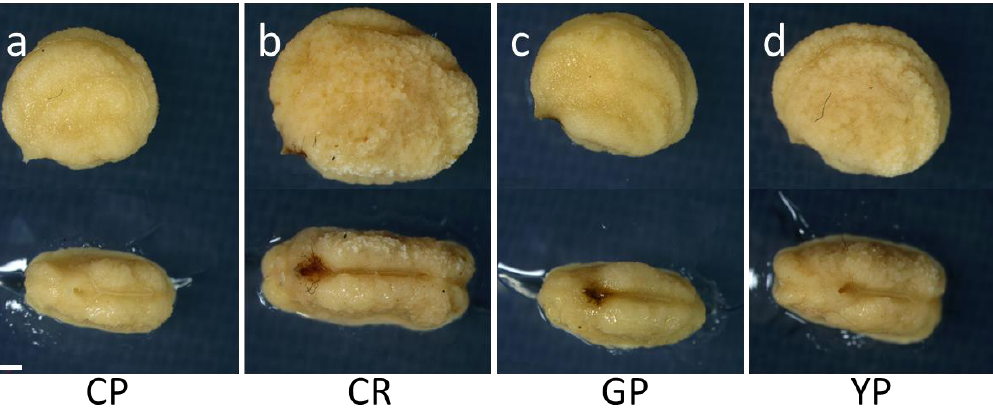
Figure 2. Morphological characteristics of indehiscent seeds depending on P. ginseng cultivar. Inde- hiscent seeds were obtained by removing the sarcocarp from the fruit for each cultivar. The seeds were evaluated for main characteristics, including weight, length, and diameter. ( a ) Chunpoong, ( b ) Cheonryang, ( c ) Gumpoong, and ( d ) Yunpoong. Scale bars, 1 mm. CP, Chunpoong; CR, Cheon- ryang; GP, Gumpoong; YP, Yunpoong.